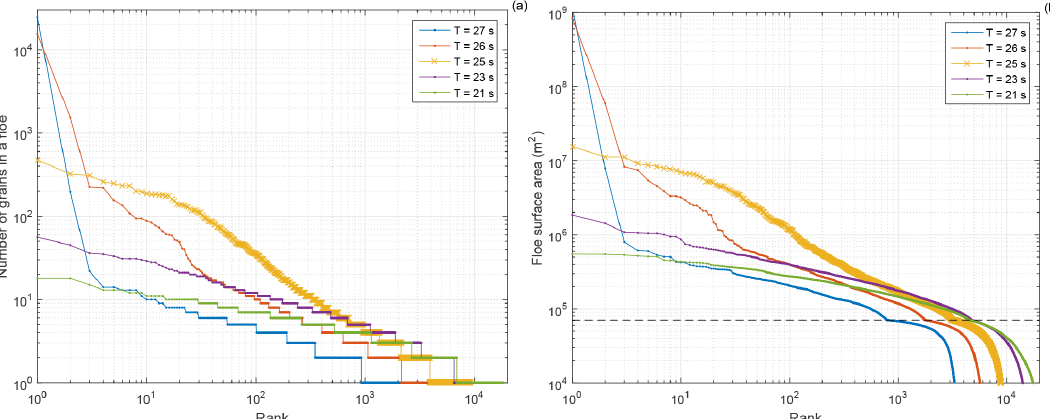
Figure 16. Rank-order statistics of floe sizes ( a : number of grains in a floe; b : floe surface area) obtained in simulations with different wave periods T . The dashed line in (b) marks the area of the largest individual grain in the ensemble. Results of the reference run are shown with